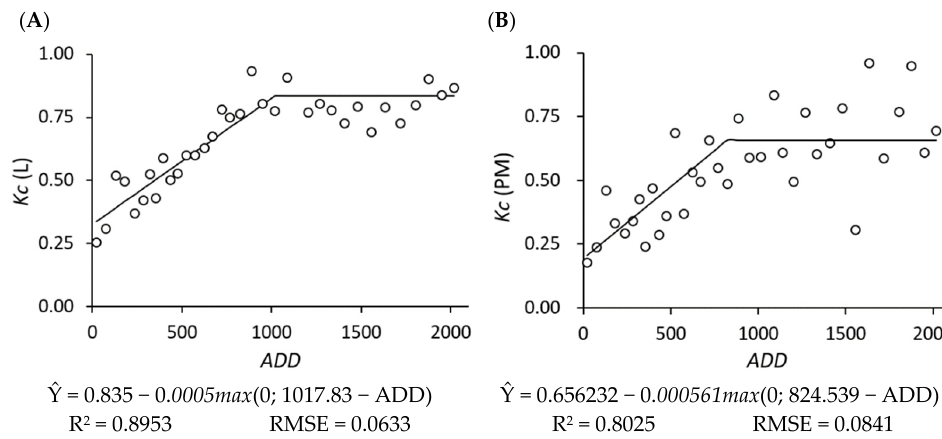
Figure 4. Crop coefficients (Kc) of strawberry cultivated with recycled paper mulch as a function of accumulated degree-days (ADD) and obtained using the ( A ) lysimeter (L) and ( B ) Penman–Monteith (PM) methods.